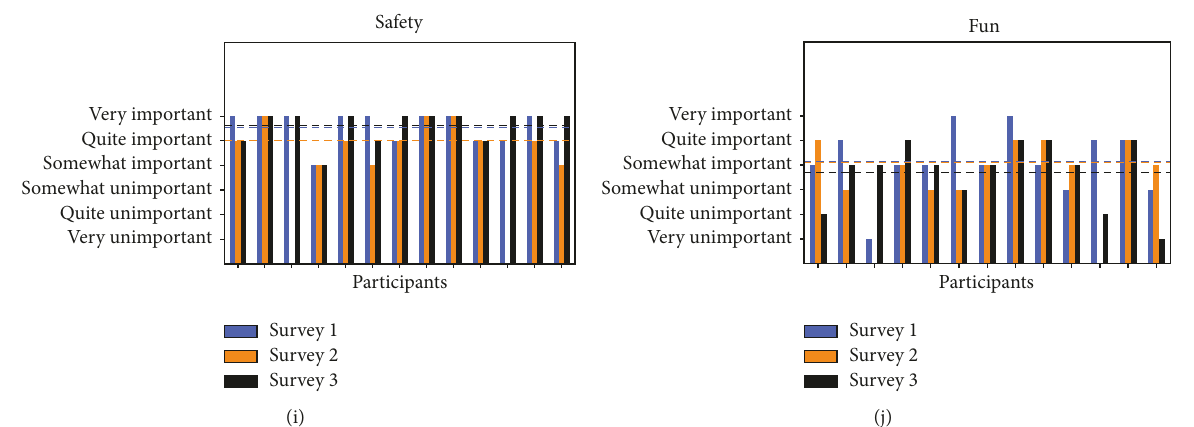
Figure 8: Evaluation of the importance of 10 different aspects of modes of transportation across three surveys, broken down by participant. Dashed lines show the mean of the responses of the survey in the respective